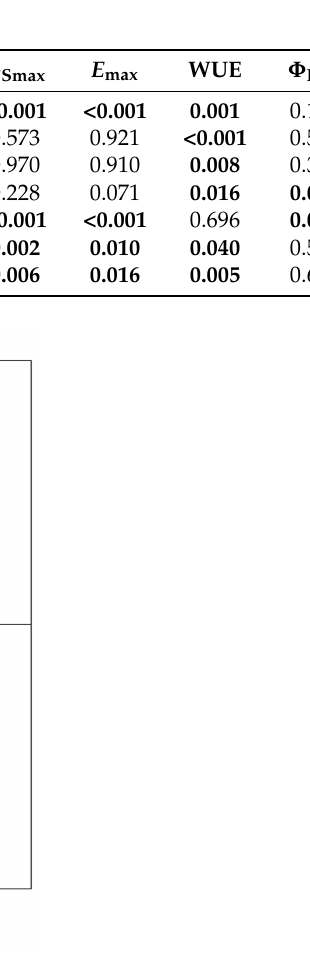
Table 1. Summary of significance levels ( p -values of the three-way ANOVA) for the factors of trees species (TS), CO 2 concentration ([CO 2 ]), water availability (WA), and their interactions ( × ) on physiological parameters ( Ψ pre-dawn —pre-dawn leaf water poten- tial, Ψ noon —noon leaf water potential, A max —light-saturated CO 2 assimilation rate, G Smax —light-saturated stomatal conductance, E max —light-saturated transpiration rate, and WUE—water use efficiency, V C —in vivo Rubisco carboxylation rate, J —in vivo electron